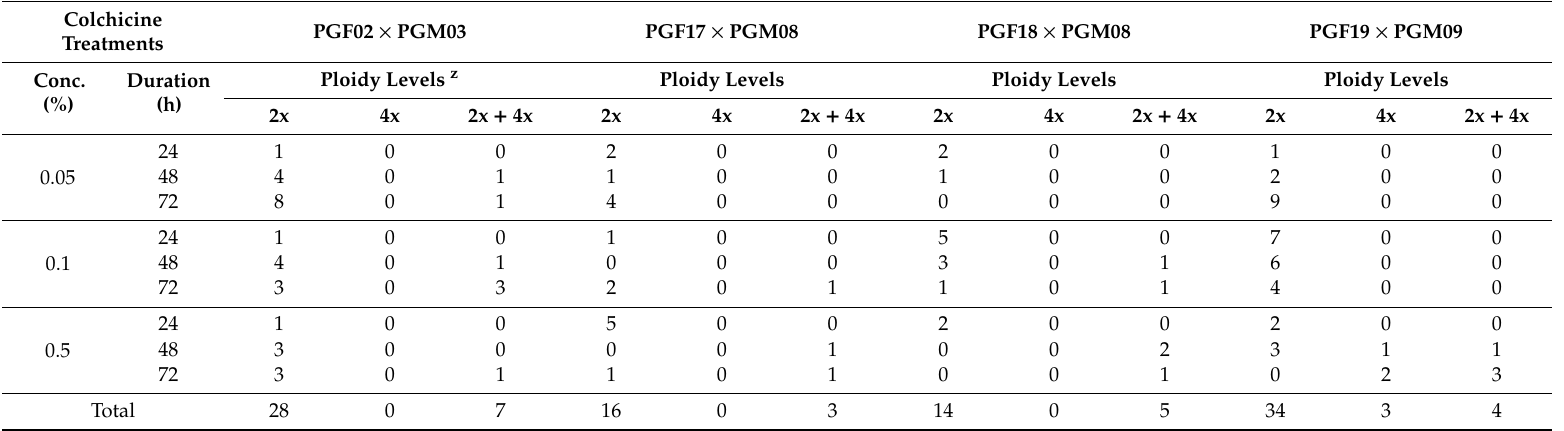
Table 2. E ff ects of colchicine treatments on the induction of polyploid seedlings in pointed